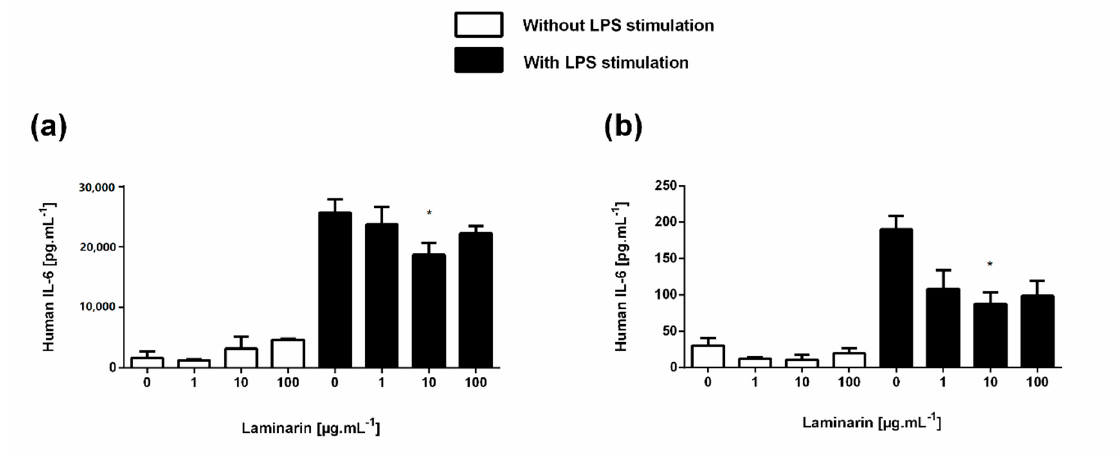
Figure 8. Quantitative analysis of IL-6 cytokine with an ELISA kit. ( a ) HDFa and ( b ) NHEK cells were stimulated with 1, 10 and 100 µg.mL − 1 laminarin for 24 h (HDFa cells) and 48 h (NHEK cells) in the absence or in presence of LPS at 10 µg.mL − 1 . An ELISA assay was performed to quantify the level of IL-6 cytokine secreted in cell culture medium supernatant. Data are expressed as mean ± SD of two independent experiments. * p ≤ 0.05, compared with 0 µg.mL − 1 (control group).